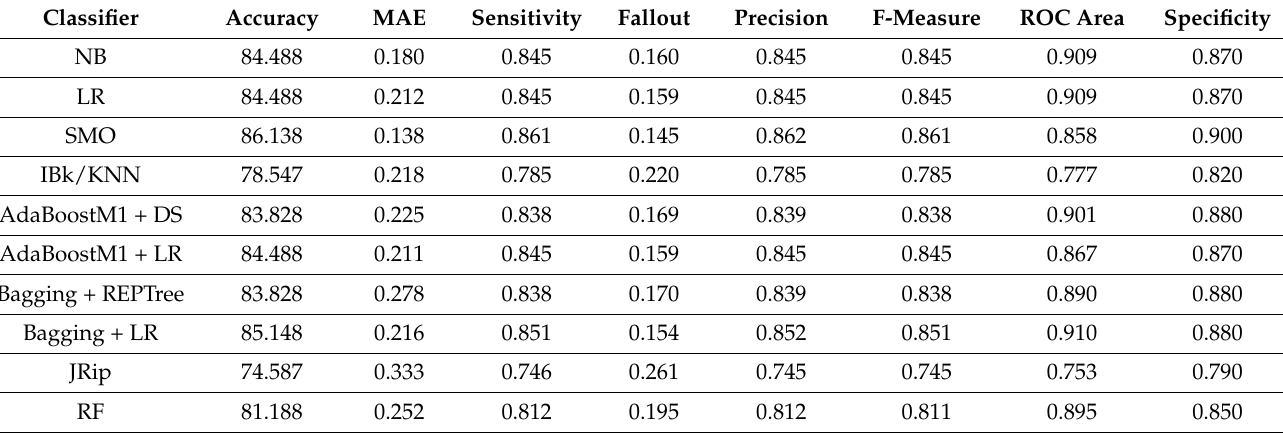
Table 10. Performance of machine learning classifiers based on the optimal attribute set using the ReliefF attribute evaluation technique.